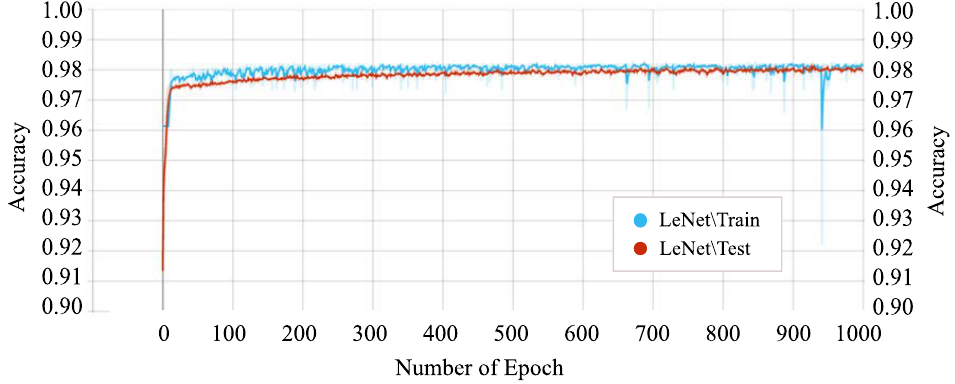
Figure 12. Training and testing accuracy of the proposed P-LeNet